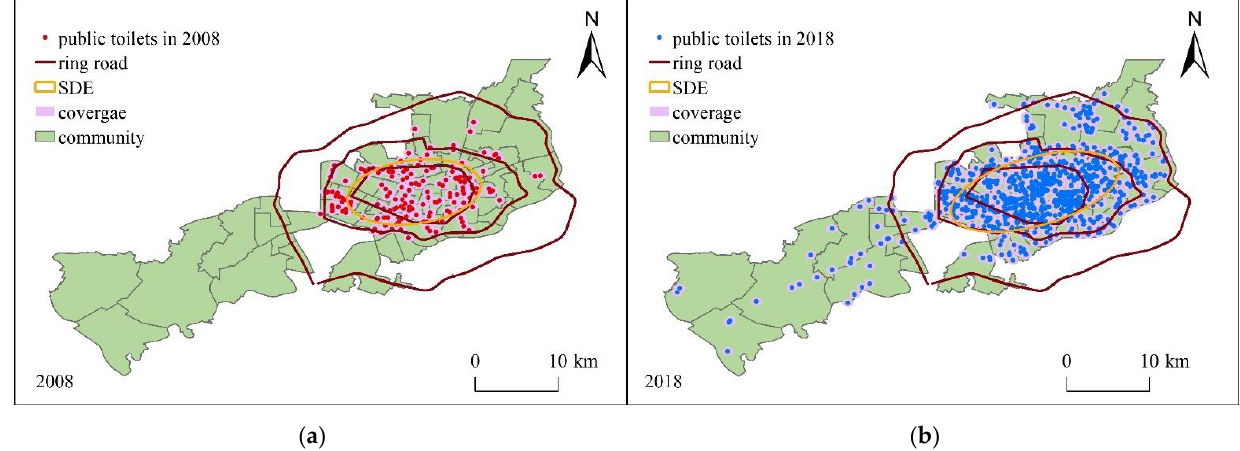
Figure 9. Distribution of standard deviation ellipse and 500 m coverage of public toilets: ( a ) distribution of SDE and 500 m coverage in 2008; ( b ) distribution of SDE and 500 m coverage in 2018.